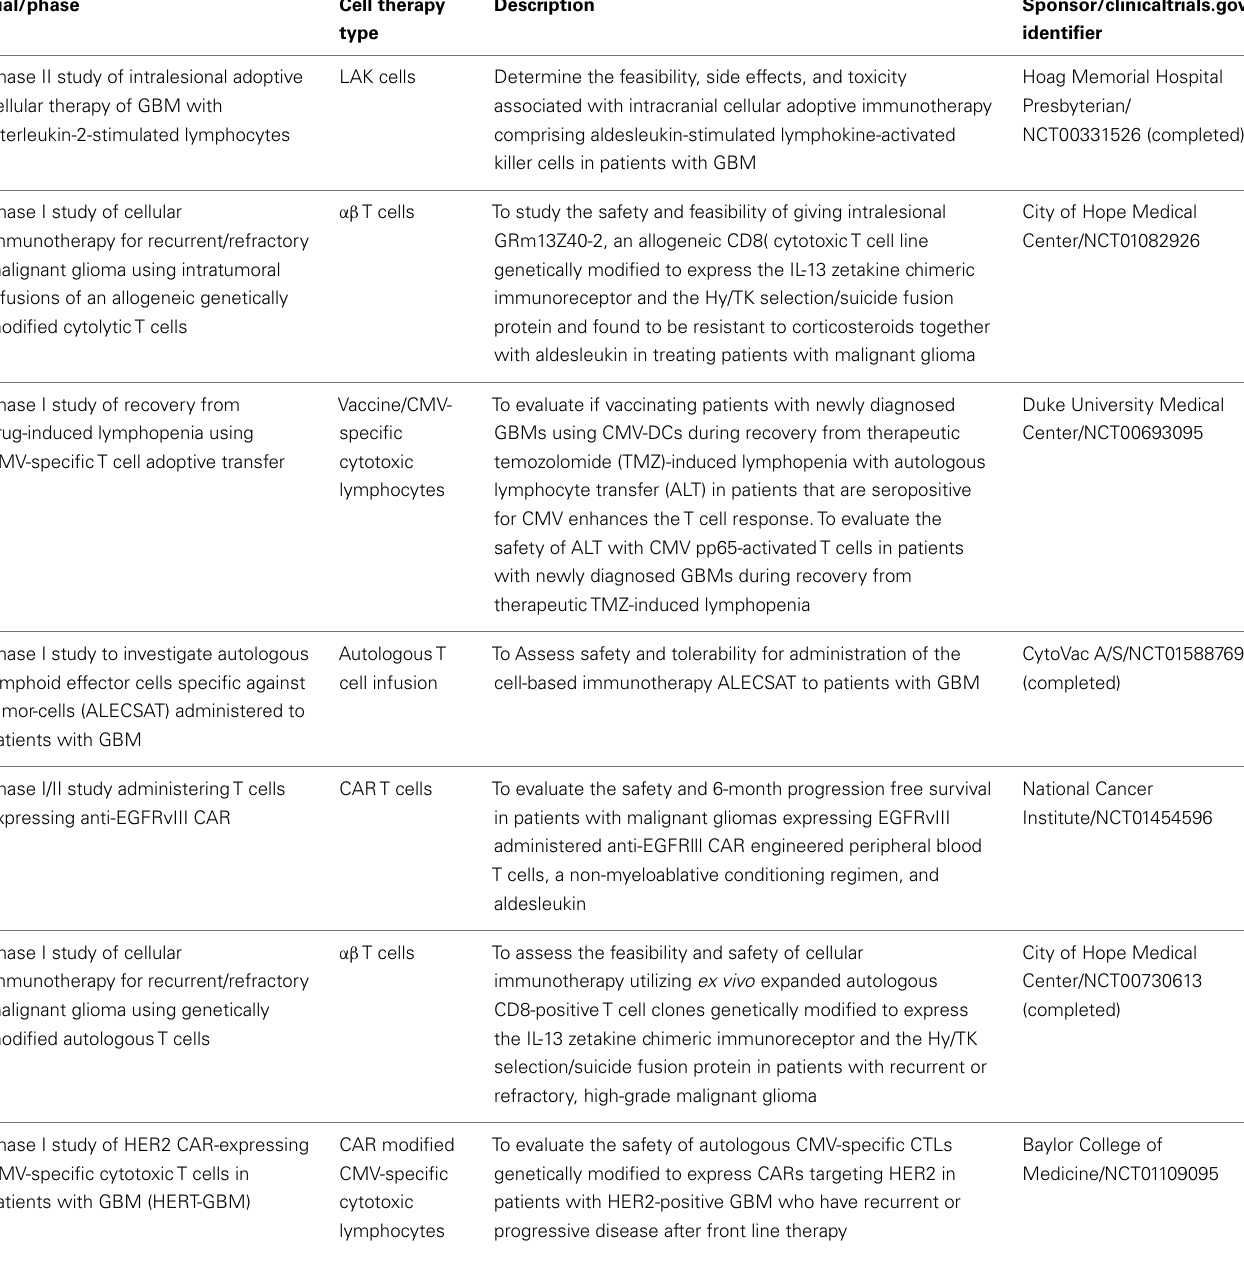
Table 2 | Current clinical trials of adoptive cellular therapy for